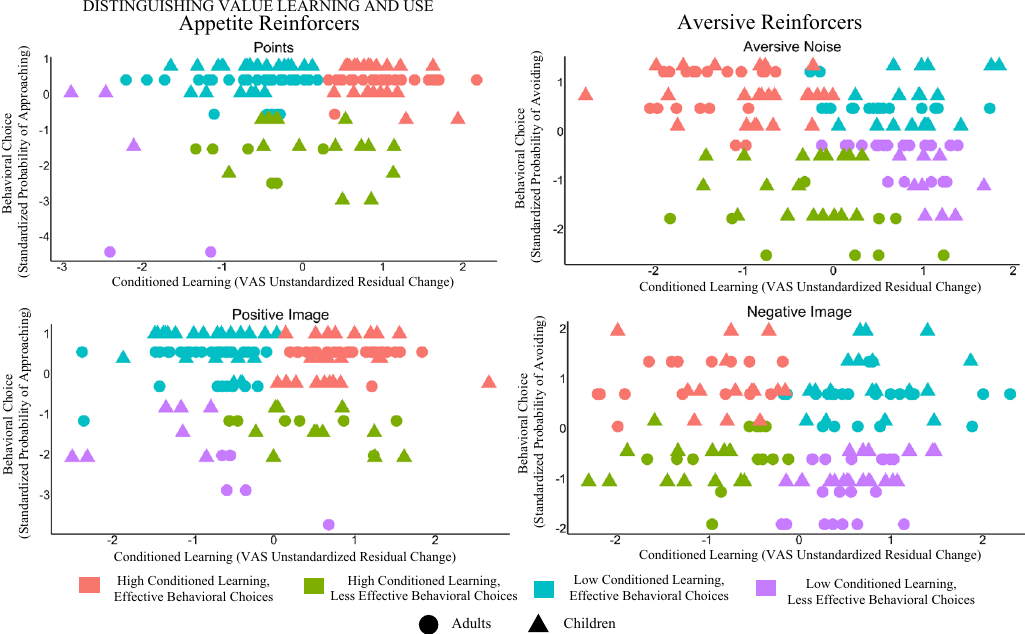
Figure 2. Clusters based on participants’ performance on the conditioning and behavioral choice tasks (for first five trials) for each reinforcer condition. Four comparable clusters of learning on the conditioning task and use on the behavioral choice task were identified for all reinforcer conditions suggestive of a separation between conditioned learning and behavioral choice based assessments of value information acquisition. They followed this general pattern: (1) Individuals who demonstrated high learning on the conditioning task and high use on the behavioral choice task (in red); (2) Individuals who demonstrated high learning on the conditioning task and low use on the behavioral choice task (in green); (3) Individuals who demonstrated low learning on the conditioning task and high use on the behavioral choice task (in blue); and (4) Individuals who demonstrated low learning on the conditioning task and low use on the behavioral choice task (in purple). All axes are standardized. VAS Visual Analogue